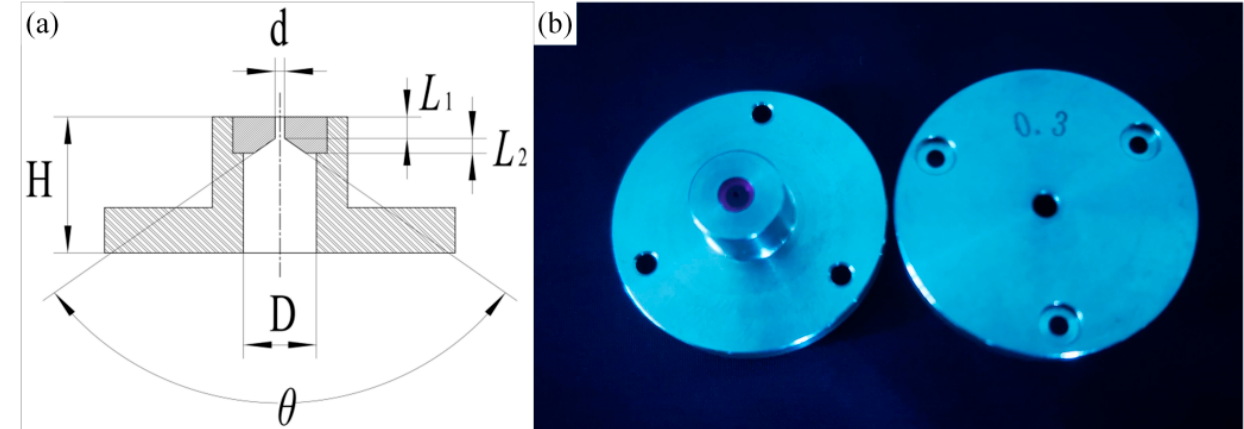
Figure 17. Nozzle model and object. ( a ) Nozzle model; ( b ) Picture of nozzle. According to the quadratic model of each response and the limited range of opti- mization objectives, a series of optimal solutions were obtained. The three groups of optimization schemes for process parameters with the highest expected values are shown in Table 11. Table 11. Process parameter optimization